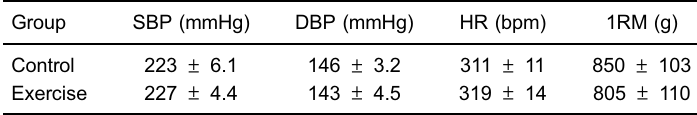
Table 1. Hemodynamic parameters and maximal load lifted in control and exercise groups.